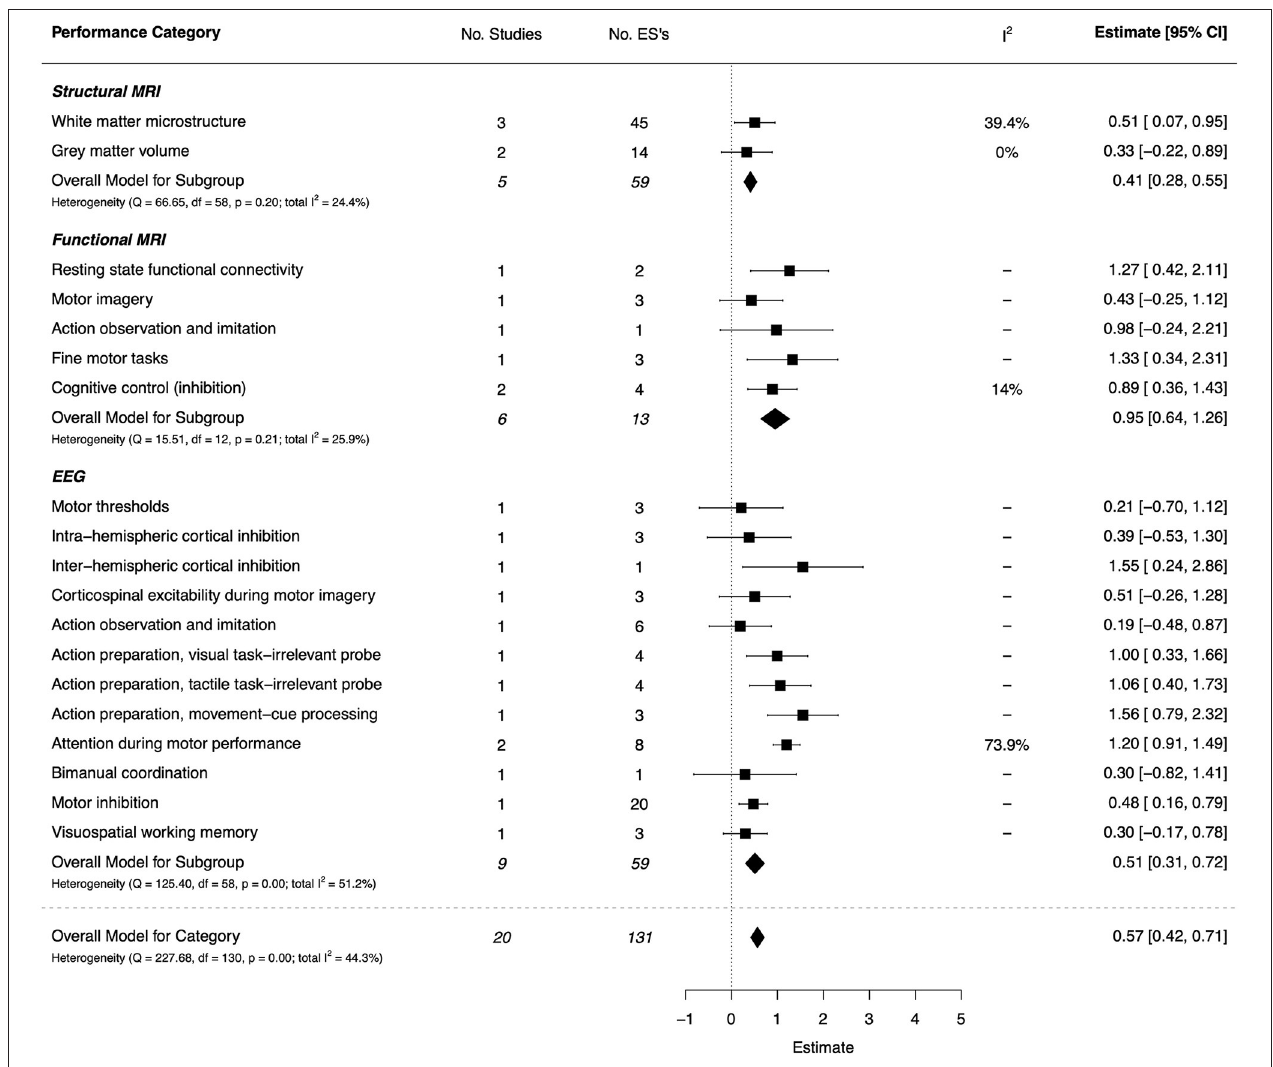
FIGURE 15 | Forest plot showing the meta-analysis results for the neuroimaging performance category. MRI, magnetic resonance imaging; EEG, electroencephalography. EEG outcomes for a Serial Prediction task are not shown in the Forest Plot. The estimate [95% CI] for these tasks are: Visuomotor Task = 22.39 [17.76, 27.02], Perceptual Task = 2.79 [1.81, 3.77], Control Task = 15.04 [11.85,